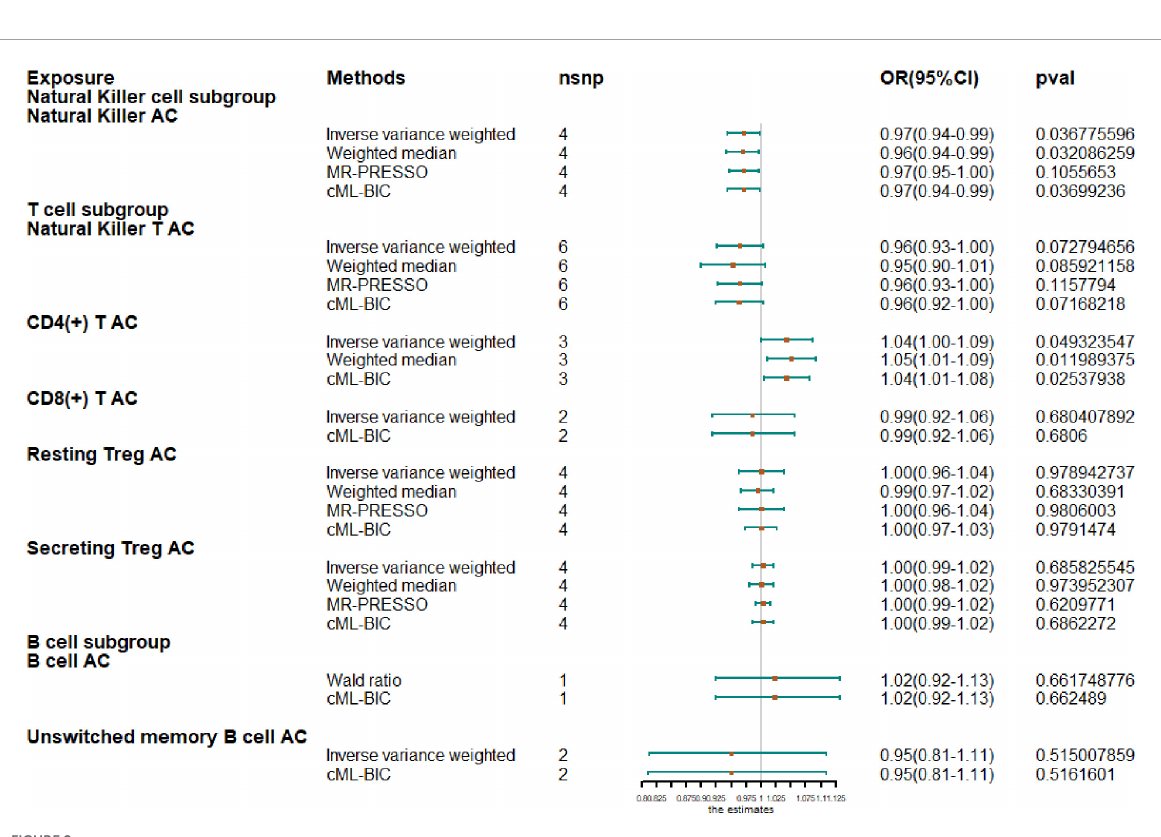
FIGURE2 Mendelian randomization results for the relationship between cell counts of lymphocyte subpopulation and atrial fibrillation. AC, absolute